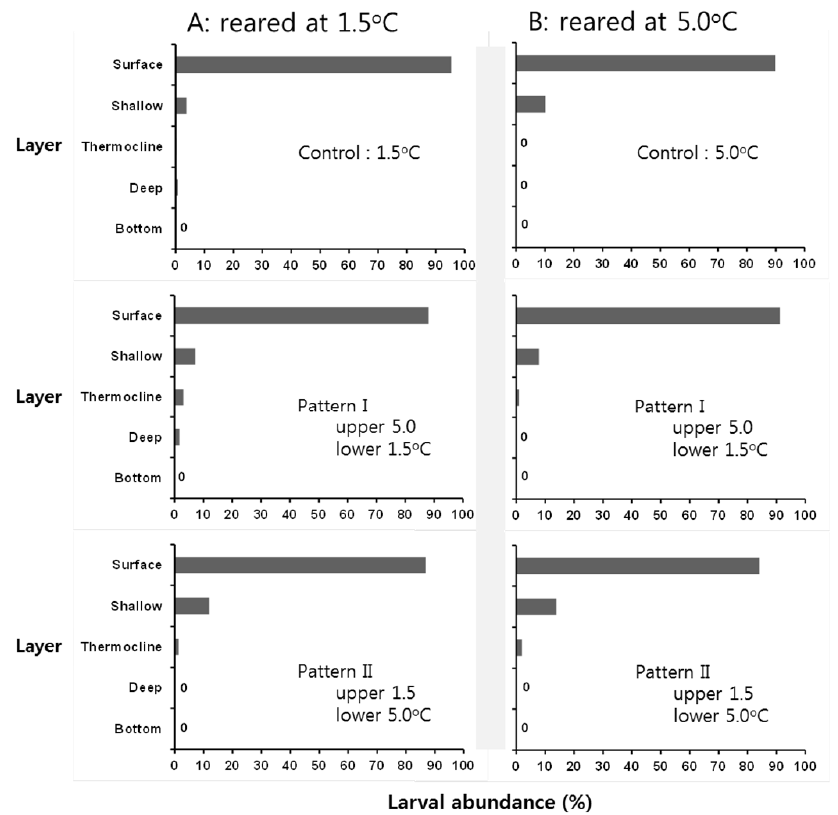
Figure 7. Relative number (%) of newly hatched walleye pollock larvae in the three hydrographic patterns; average calculated from six replicates ( n = 610).